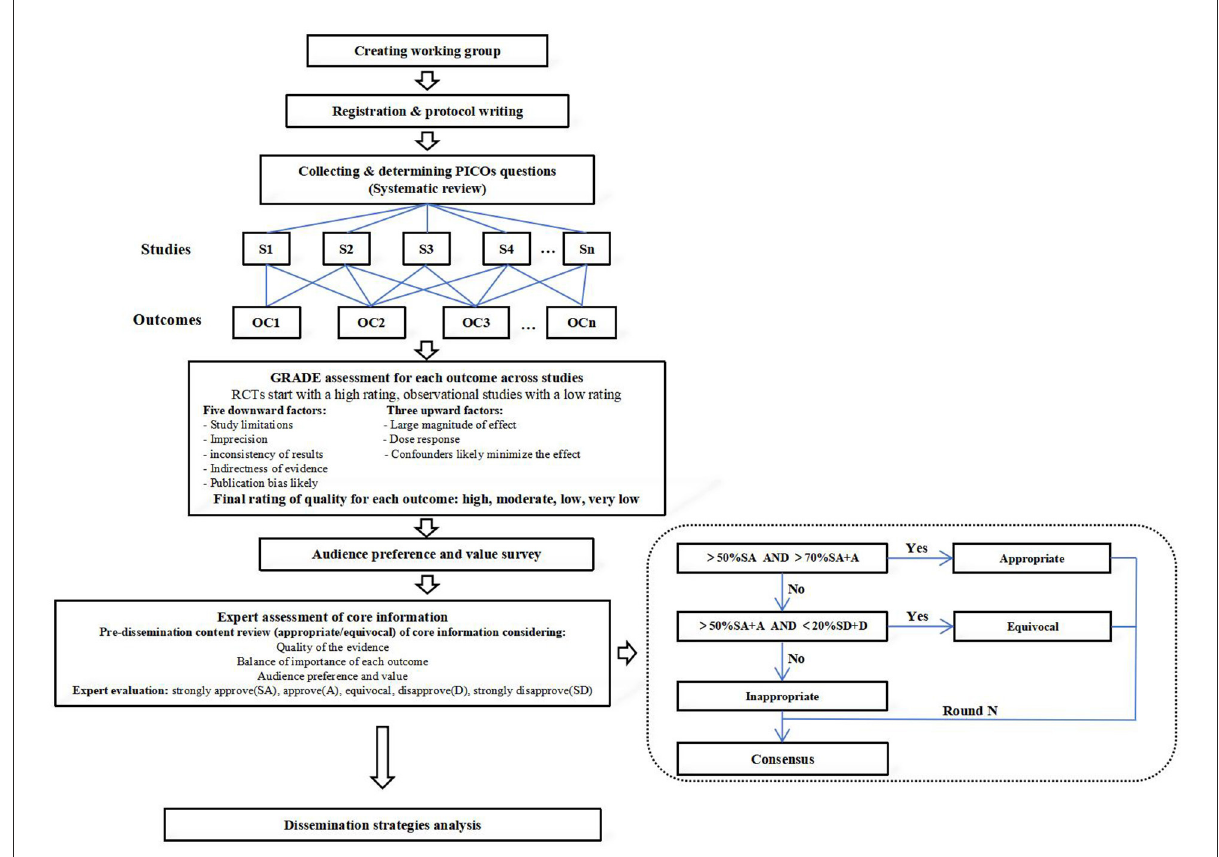
FIGURE1 The technical route for development of Evidence-based Core Information for Health Communication of Tobacco Control.